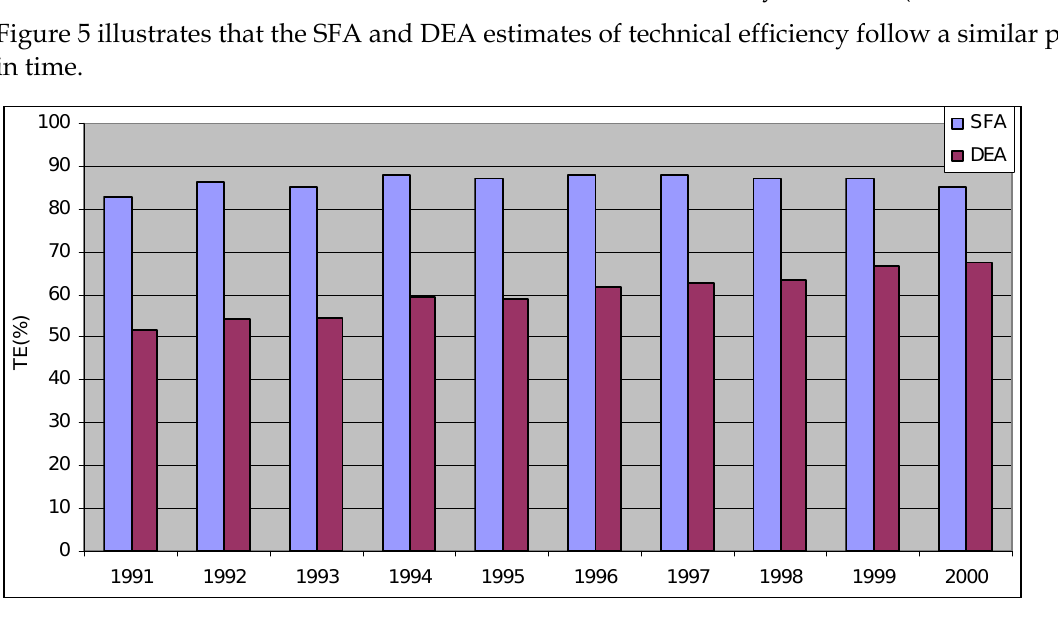
Figure 5. Average Annual Technical